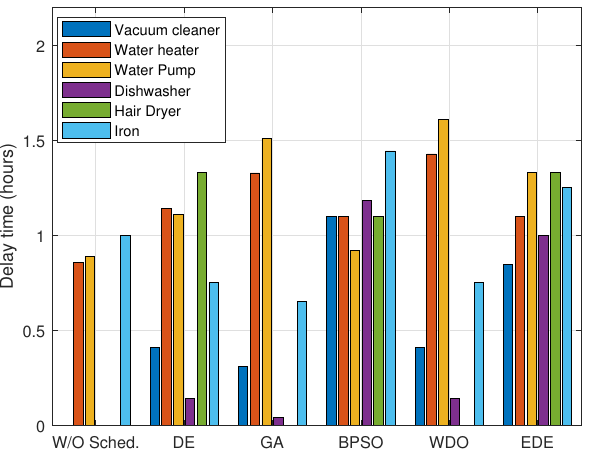
Figure 12. User comfort in aspects of average waiting time/delay time after scheduling interrupt- ible